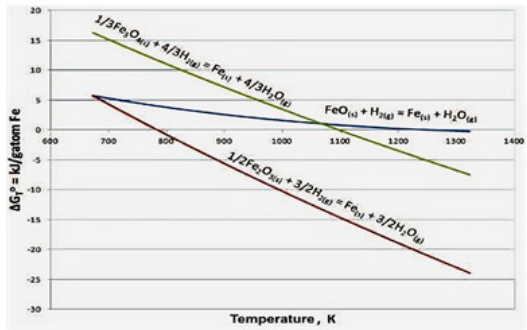
Figure 3. The changes of the Gibbs free energy with the temperature of the reactions of reduction with hydrogen H (mill scales) 13 .